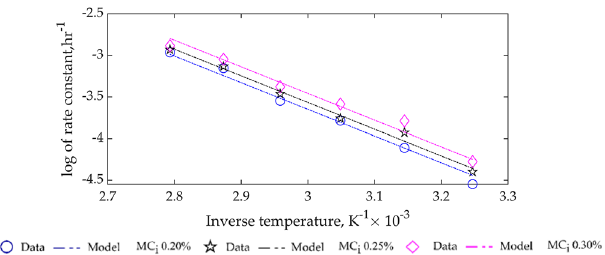
Figure 4. Variation of rate constant for CPO FFA kinetics with temperature for different MC i .